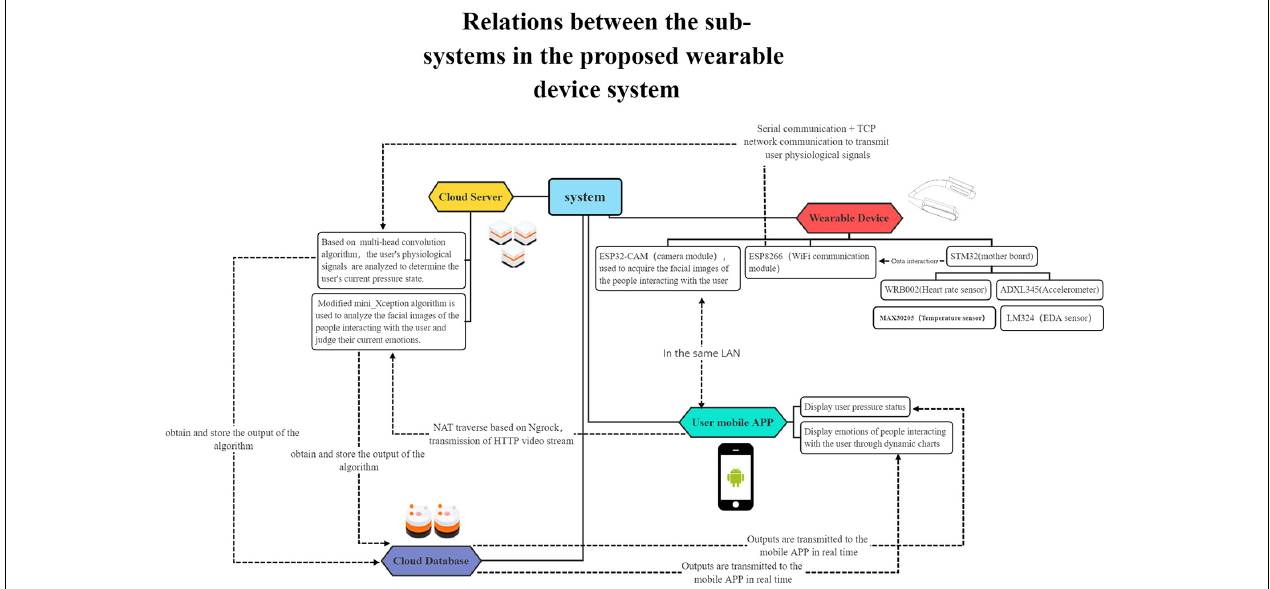
FIGURE 1 | Relations between the sub-systems in the proposed wearable device